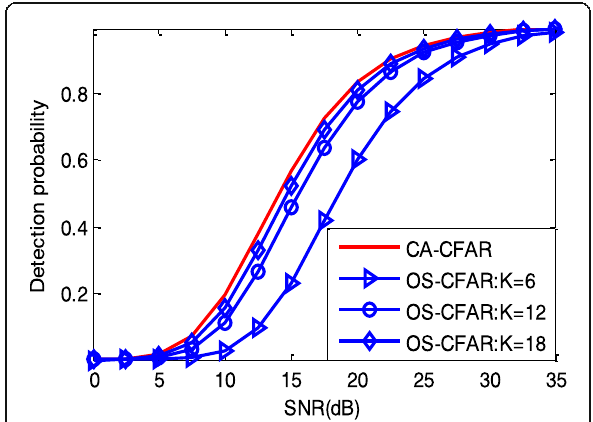
Fig. 6 Performances of CA-CFAR and OS-CFAR detectors in a homogeneous